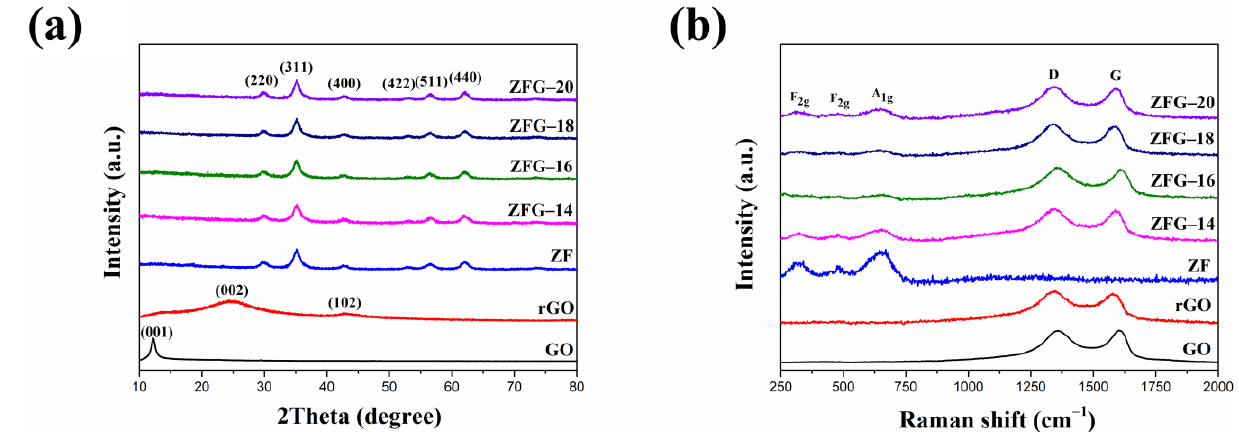
Figure 2. ( a ) XRD pattern and ( b ) Raman spectra of GO, rGO, ZF, and ZFGs. Table 1. D and G band location and I D /I G value of GO, rGO, and ZFGs.